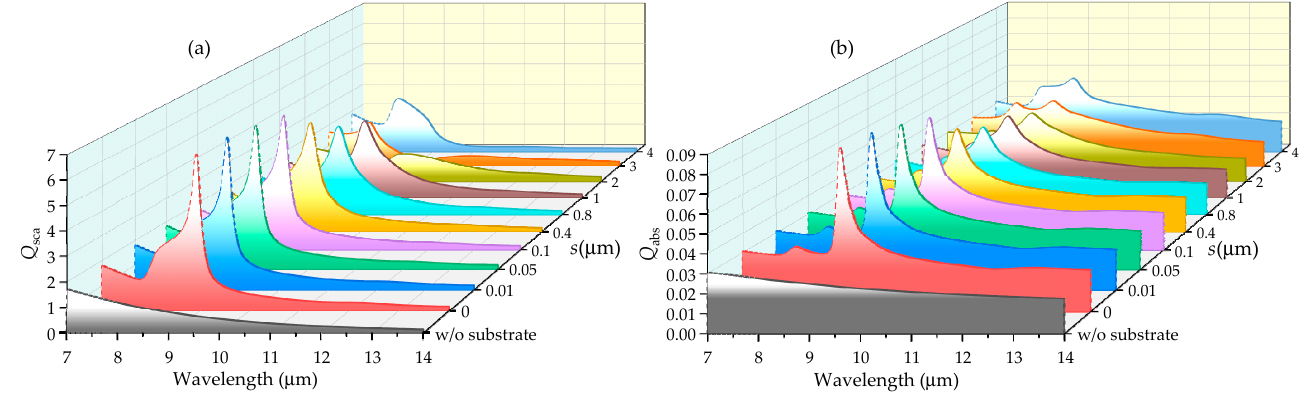
Figure 7. Infrared properties of an Al sphere on the SiO 2 substrate versus the wavelength and particle-to-substrate distance s, where curves of different colors correspond to different distances s of particles to the substrate : ( a ) scattering and ( b ) absorption efficiencies. For convenience, the efficiencies of a free particle without the substrate are also shown. The radius of the Al sphere is 1 µm.